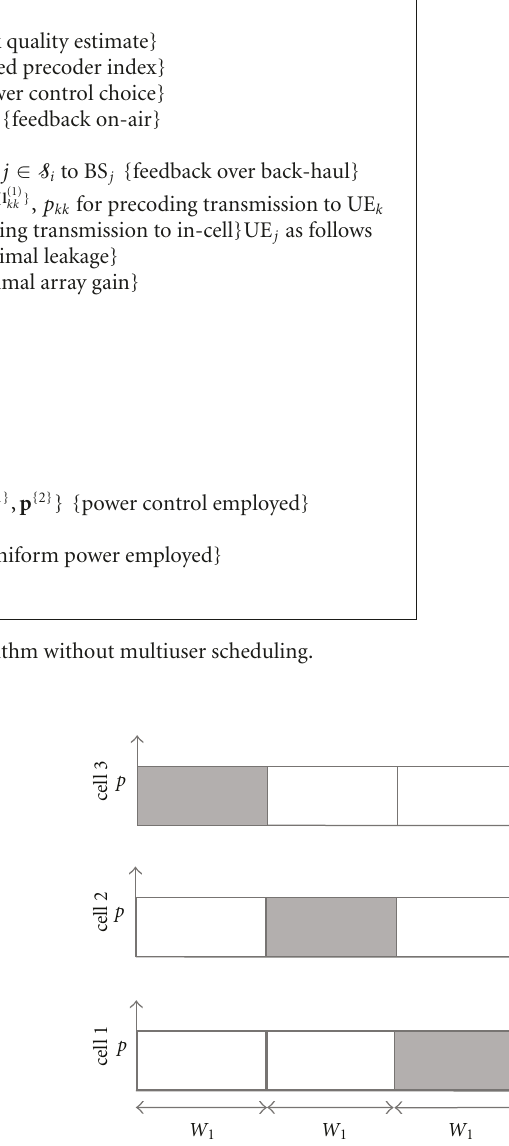
Figure 4: Spectrum sharing framework illustrated: the shaded part of the spectrum is used by cell edge